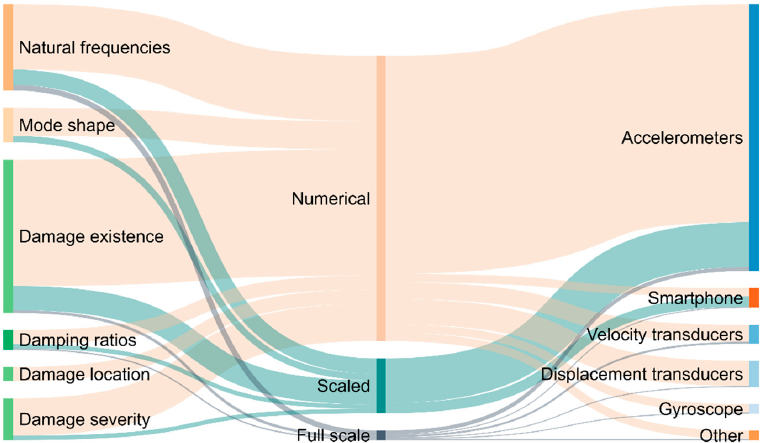
Figure 2. Interconnection between scope (structural modal identification and damage detection), publication type, and sensing units.